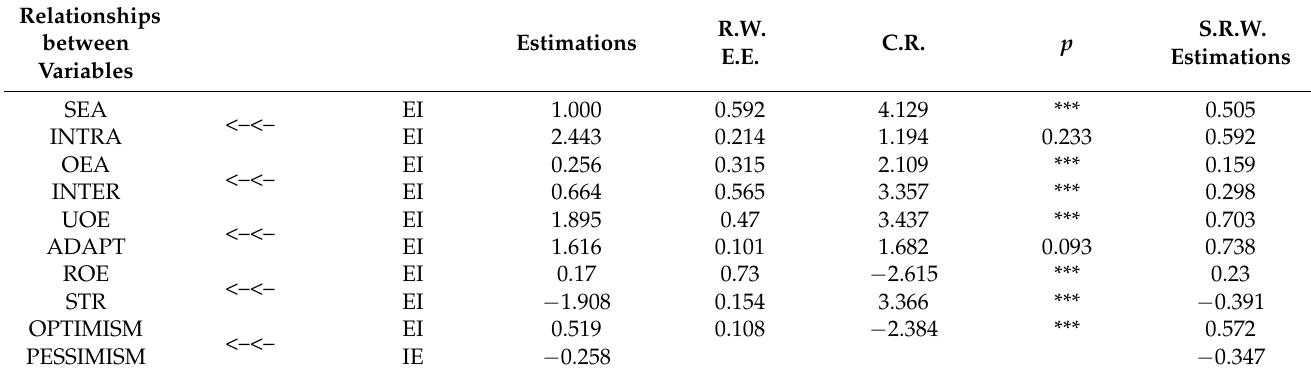
Table 4. Regression weights and standardised regression weights for men.